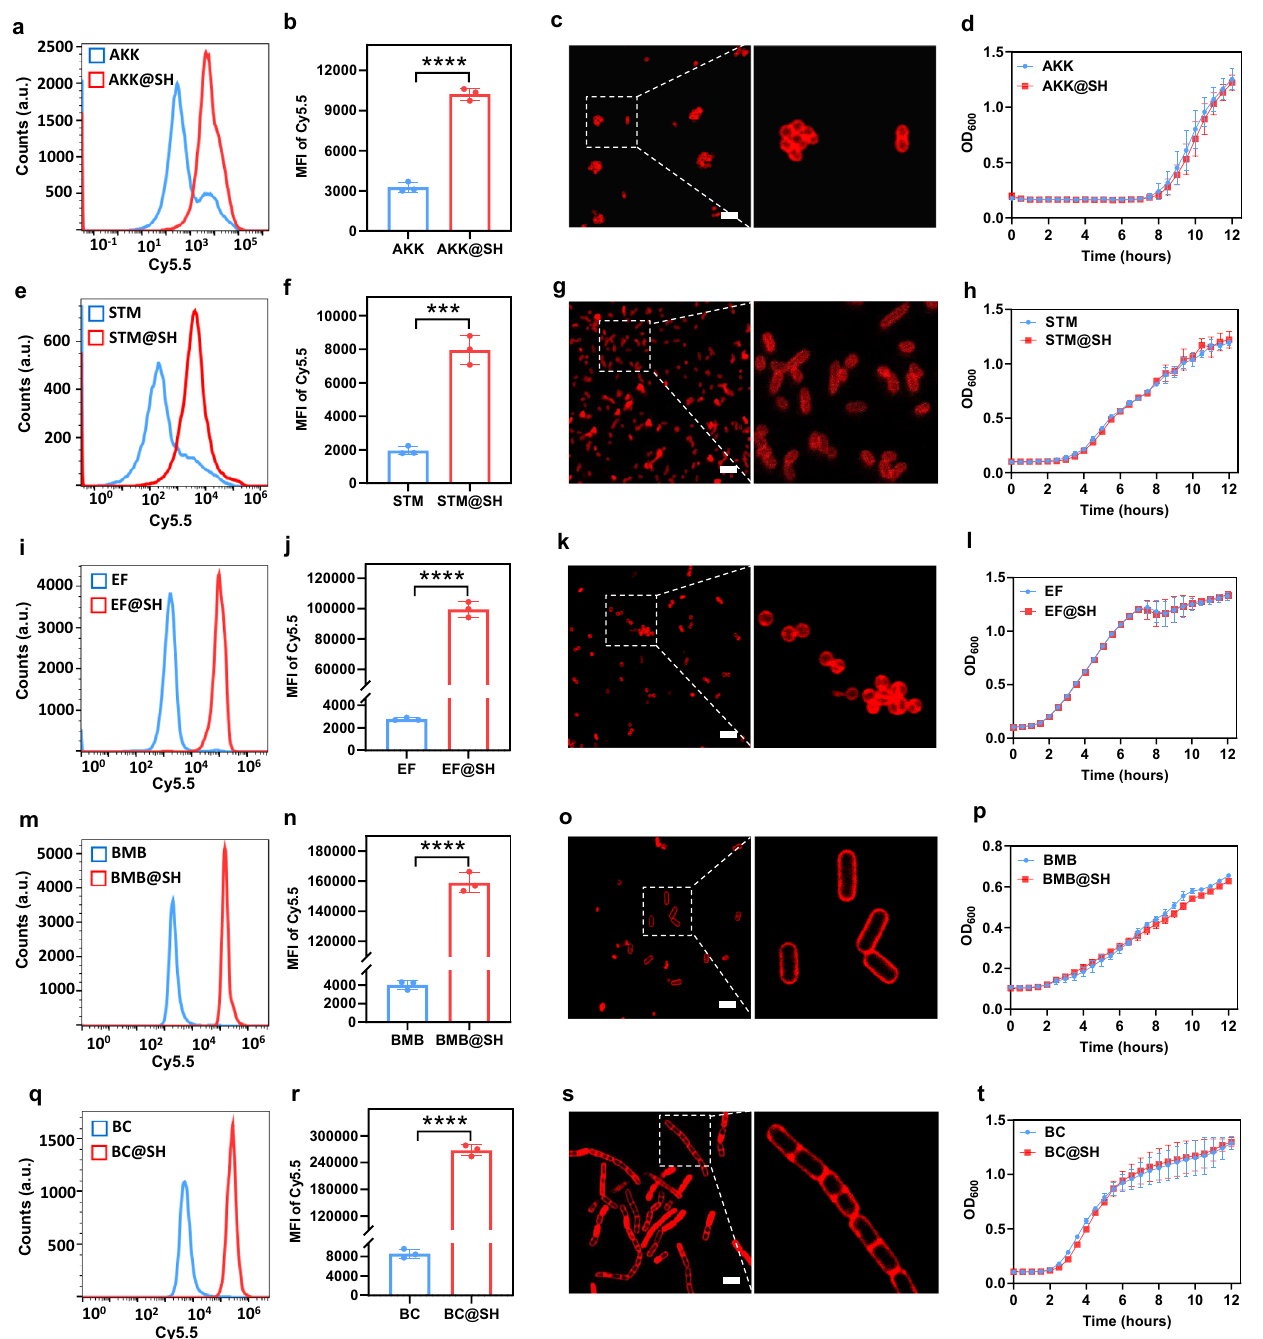
d , h , l , p , t Growth curves of thiolated ( d )AKK,( h ) STM, ( l ) EF,( p )BMB,and ( t ) BC. Native bacteria were used as controls. The a.u. indicates arbitrary units. Data are presented as mean values±SD ( n =2 – 4, from independent experiments). Sig- ni fi cance was assessed using Student ’ s t test (two-tailed), giving P